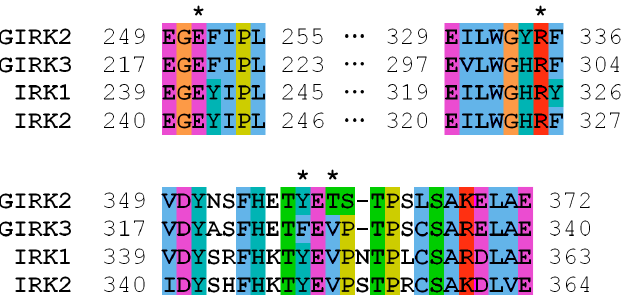
Figure 2. Homology modeling of GIRK3. ( a ) Modeled GIRK3 subunit. The template GIRK2 structure (3sya, tetrameric assembly) is shown in white, and GIRK3 is shown in lime. ( b ) Molecular environ- ment of the residue 326 in GIRK3 (colored by atom type) and GIRK2 (white). ( c ) Phe326Ser substi- tution in GIRK3. The GIRK2 subunit (3sya) comprising the glutamate residue is shown in white. The figure was prepared using VMD [29].